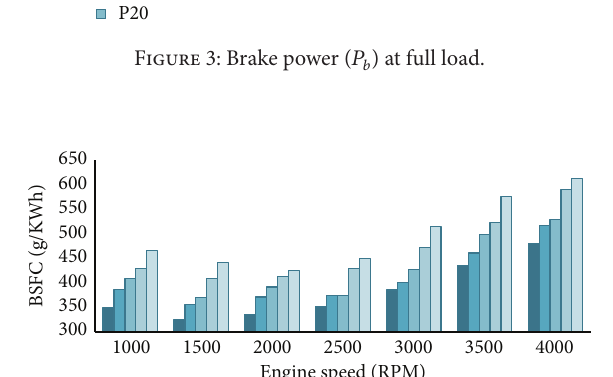
Figure 5: Brake thermal efficiency of all tested fuel blends at full load and various